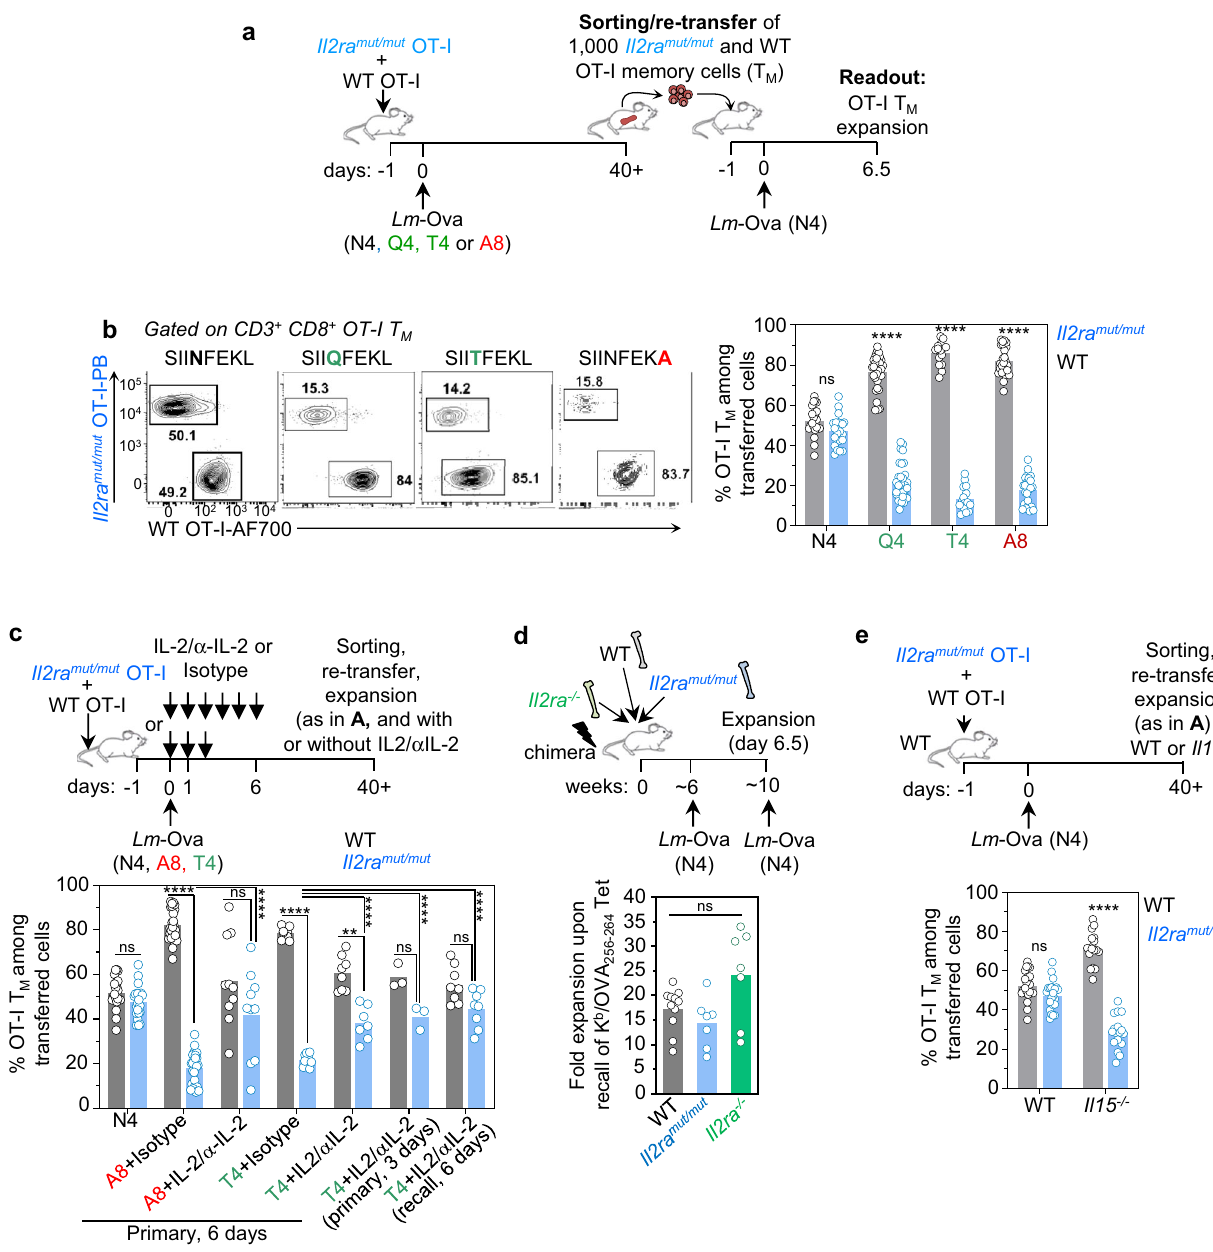
Fig. 2 CD8 + T cells primed with weak TCR and IL-2 signals failed to form memory cells that competitively expand during recall infection. a Schematic of experimental design used or referred to in B, C, E. Brie fl y, 2000 Il2ra mut/mut or WT OT-I cells expressing constitutive tomato (Td) and congenically distinct, were adoptively transferred to recipient mice, and infected the next day with Lm -Ova N4, Q4, T4 or A8. 1000 Il2ra mut/mut and WT OT-I memory cells (~day 40 p.i.) were then sorted by FACS and transferred at a 1:1 ratio to new recipient mice subsequently infected with Lm -OvaN4 the next day. 6.5 days later, spleens were harvested and stained to quantify Il2ra mut/mut and WT OT-I memory cell expansion. ( b ) Following (A), representative FACS dot plots of re-expanded Il2ra mut/mut and WT OT-I memory cells originally primed with the indicated Ova APLs are shown. Bar graph represents the pooled frequencies of re-expanded Il2ra mut/mut versus WT OT-I memory cells across >6 independent replicate experiments ( n = 30 mice). c As in (A), but mice were also injected with IL-2/anti-IL2 mAb complexes during initial or recall infection, every day for 6 or 3 days as depicted on the schematic and in Supplementary Fig. 2b. The bar graph shows the relative average frequency of re-expanded Il2ra mut/mut and WT OT - I memory cells across 1 – 4 independent replicate experiments ( n = 3 – 30 mice). d WT/ Il2ra mut/mut / Il2ra − / − mixed BM chimeras (ratio 1:1:1) were infected i.v. with Lm -OvaN4 and challenged 4 weeks later with Lm -OvaN4. 6.5 days later, splenocytes were stained with Ova 257 – 264 /K d tetramers (Tet + ) and appropriate congenic markers. Bar graphs show the relative fold expansion of Tet + CD8 + T cells across 2-3 independent replicate experiments (n = 11 mice). e As in (A), but FACS-sorted Il2ra mut/mut and WT OT - I memory cells were adoptively transferred to either WT or Il15 − / − hosts. The bar graph shows the summary of the relative frequency of re- expanded Il2ra mut/mut and WT OT - I memory cells across 4 – 5 replicate experiments ( n = 17 mice for transfer into WT ( p = 0.0907) and − 24 mice for transfer in Il15 − / − hosts ( p < 0.000001)). In all panels, each symbol represents 1 mouse and p -values are indicated when relevant with * p < 0.05; ** p < 0.01; *** p < 0.001; **** p < 0.0001; ns, not signi fi cant, using two-tailed unpaired Student ’ s t